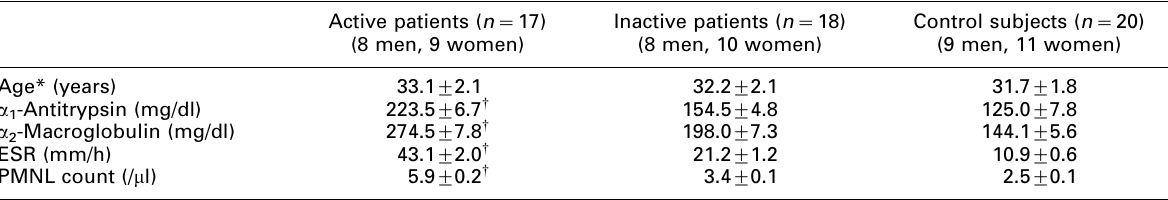
Table 2. Comparative analysis of acute phase reactants a 1 -antitrypsin and a 2 -macroglobulin, erythrocyte sedimentation rate and polymorphonuclear leukocyte count in patients with active or inactive Behc¸et’s disease and healthy control volunteers: statistical